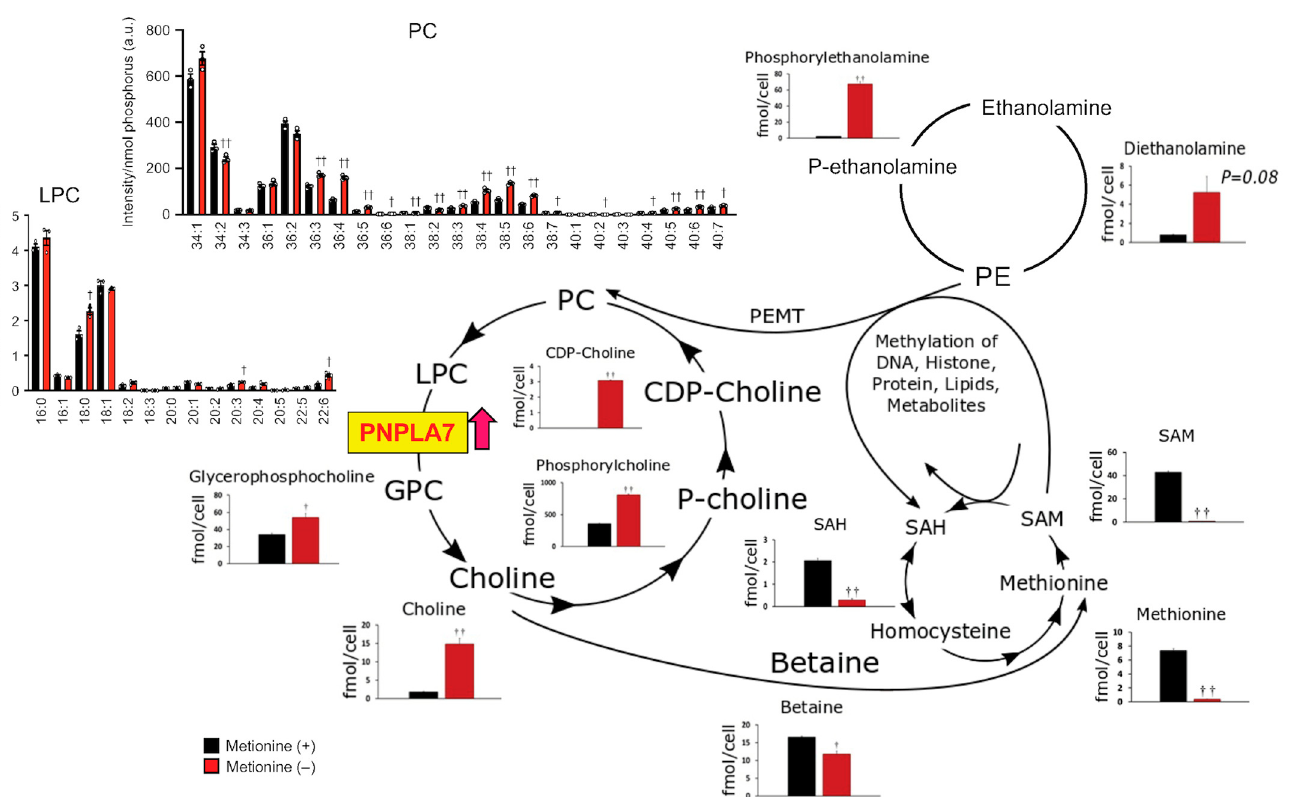
Figure 4. Effect of methionine deprivation on the choline and methionine cycles in HepG2 cells. Graphs represent the levels of individual metabolites in HepG2 cells cultured with (+) or without ( − ) methionine for 48 h. PNPLA7 is upregulated in cells cultured in methionine-free medium (see Figure 3). Quantification of lipids (PC, LPC, and PE) and water-soluble metabolites were performed by LC–MS and CE–MS, respectively [14]. Mean ± SEM ( n = 4); †, p < 0.05; ††, p < 0.01; two-tailed Student’s t -test. For details, please see the text.